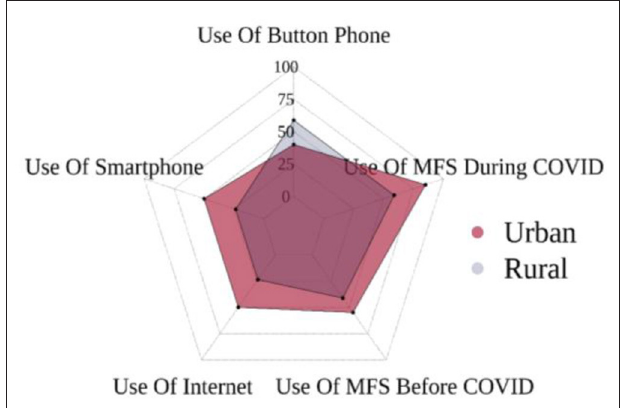
FIGURE 4 | Difference between the urban and rural participants in terms of percentage of participants using button phone, smartphone, internet, mobile financial service (MFS) before COVID, and MFS during